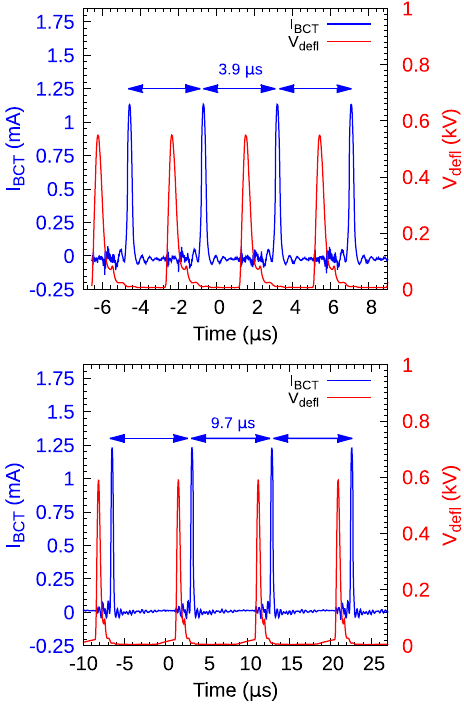
FIG. 11. Measured 14 keV He þ beam pulses with a repetition rate of 257 kHz (top) and 103 kHz (bottom). The signal of the BCT I is depicted in blue and the voltage V BCT positively charged deflection plate in red. The original BCT data without rf noise correction or baseline restoration are